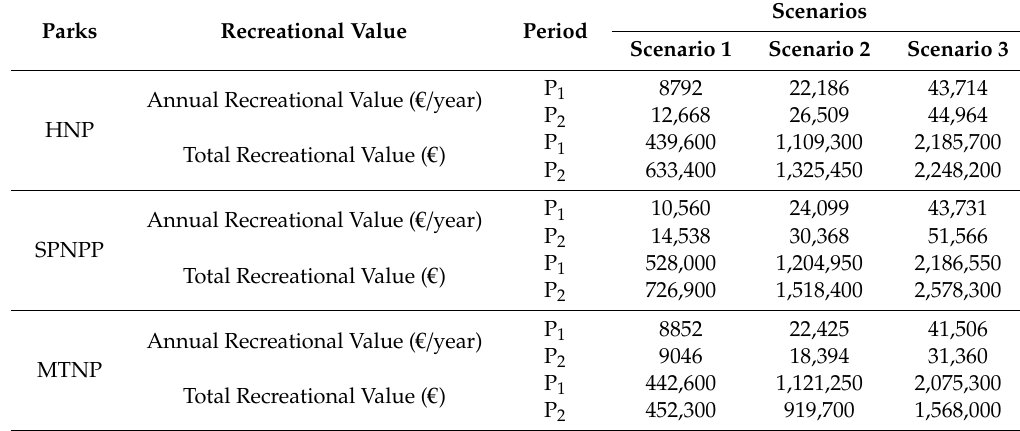
Table 14. Willingness to Pay for an entrance fee (WTP) to visit the Natural Parks ( € ). Natural